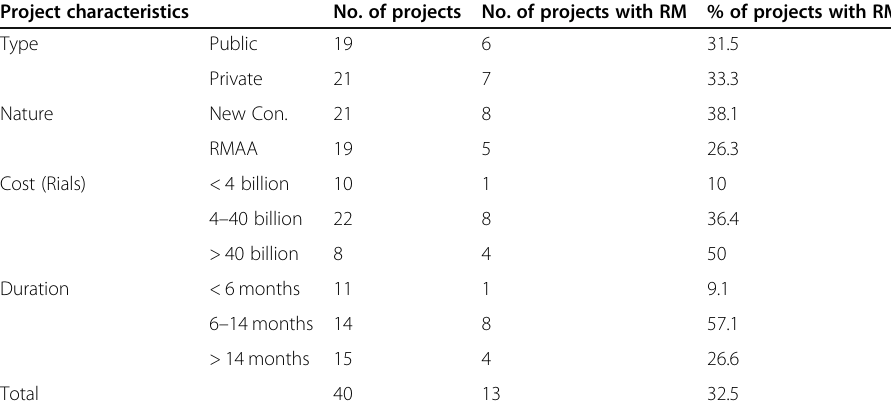
Table 7 Status of RM implementation: project level Project